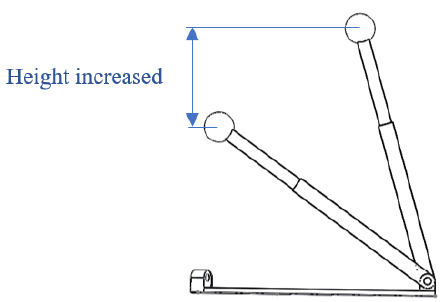
Figure 13. Mechanism of revolute joints participating in compensation to heave motion.